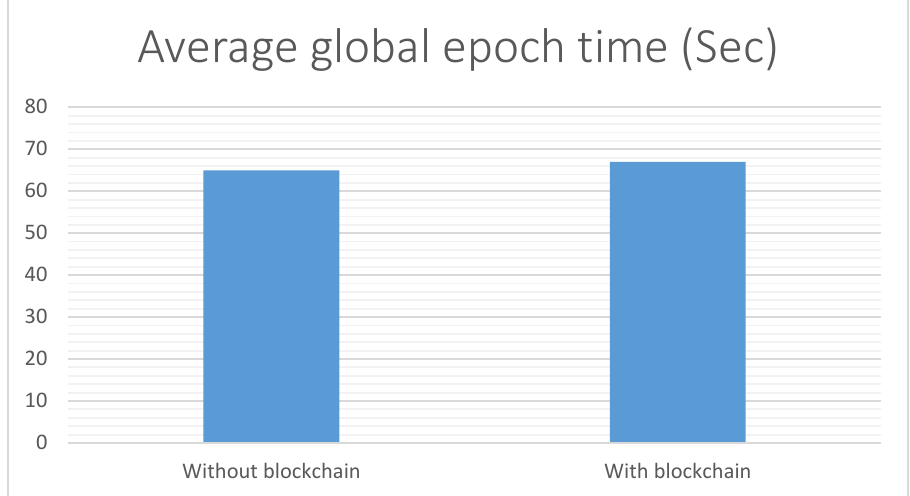
Figure 9. Average global epoch time with and without blockchain.